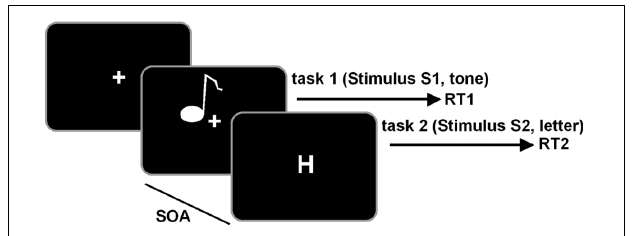
FIGURE 1 | Schematical illustration of the PRP paradigm. The tone task is always presented first and the letter task is always presented second in a defined stimulus-onset asynchrony (SOA). Participants are required to respond first on the tone and second on the letter task.